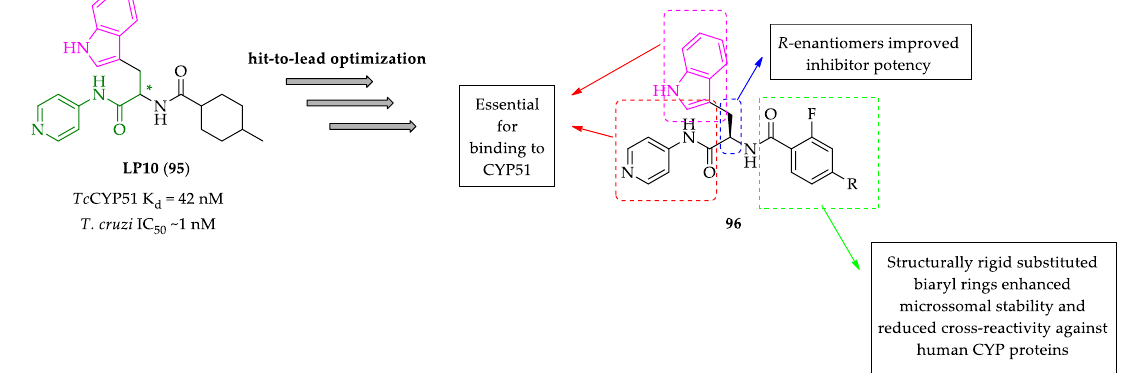
Figure 13. SAR for indolylpirimidinecarboximide-based Tc CYP51 inhibitors.